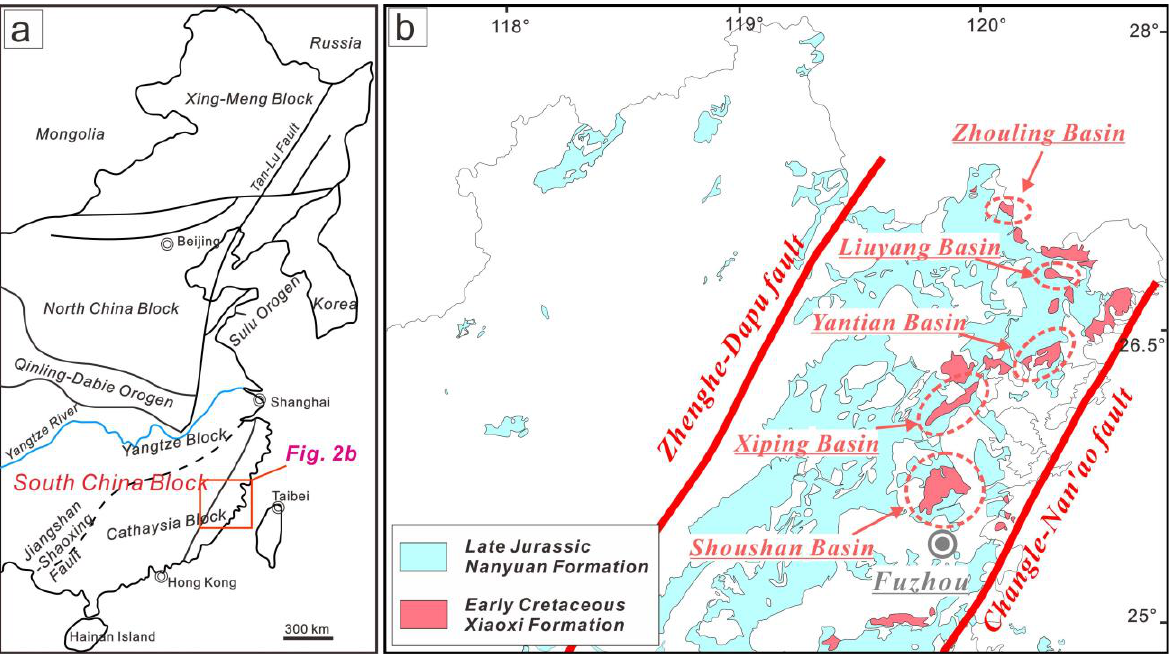
Figure 2. ( a ) Schematic map of geotectonic units in eastern China. ( b ) Schematic map of the Late Jurassic Nanyuan Formation and Early Cretaceous Xiaoxi Formation in Southeastern Fujian Province.